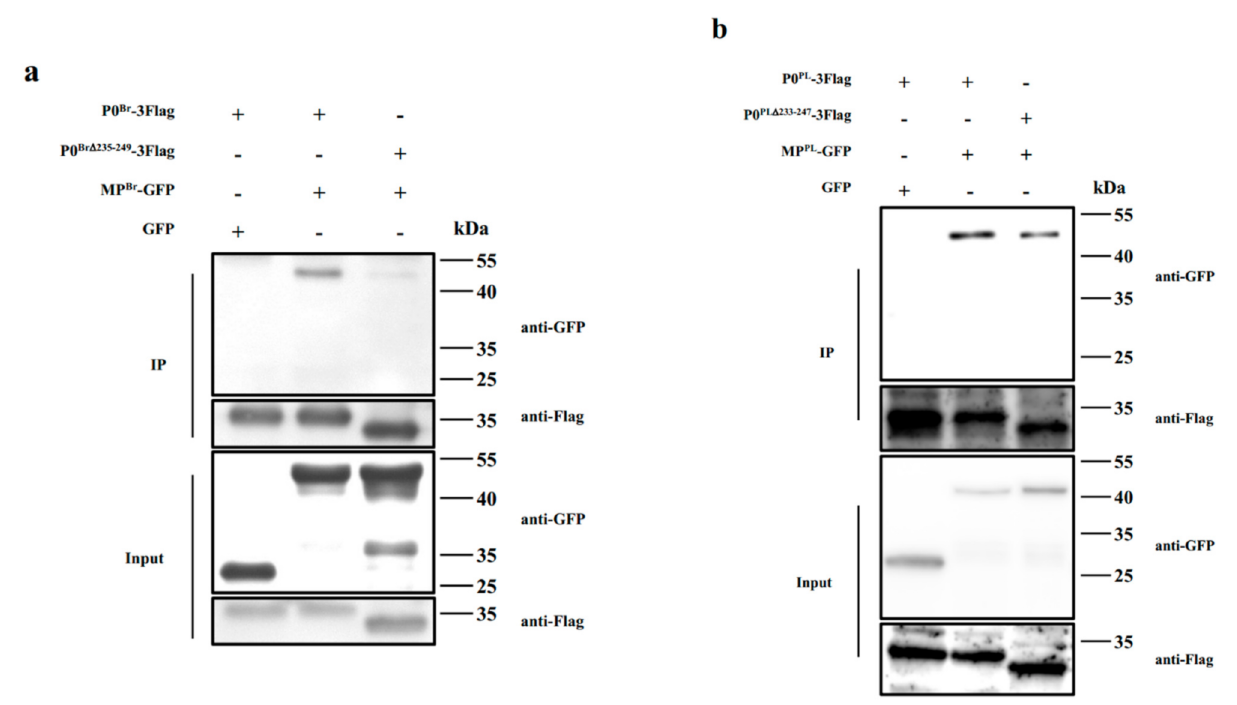
Figure 9. Both the P0 C-terminal truncated mutants and wild types of BrYV and PLRV interacted with their MPs. ( a ) Co-immunoprecipitation analyses of P0 Br and MP Br proteins in N. benthamiana leaves. P0 Br -3Flag was co-expressed with MP Br in N. benthamiana . P0 Br -3Flag was co-expressed with MP Br in N. benthamiana . P0 Br -3Flag and GFP were used as negative controls. ( b ) Co-immunoprecipitation analyses of P0 PL and MP PL proteins in N. benthamiana leaves. P0 PL -3Flag was co-expressed with MP PL in N. benthamiana . P0 PL -3Flag and GFP were used as negative controls. Protein complexes were immunoprecipitated using anti-Flag beads. The co-immunoprecipitated proteins were probed with a GFP antibody (anti-GFP) and a Flag monoclonal antibody